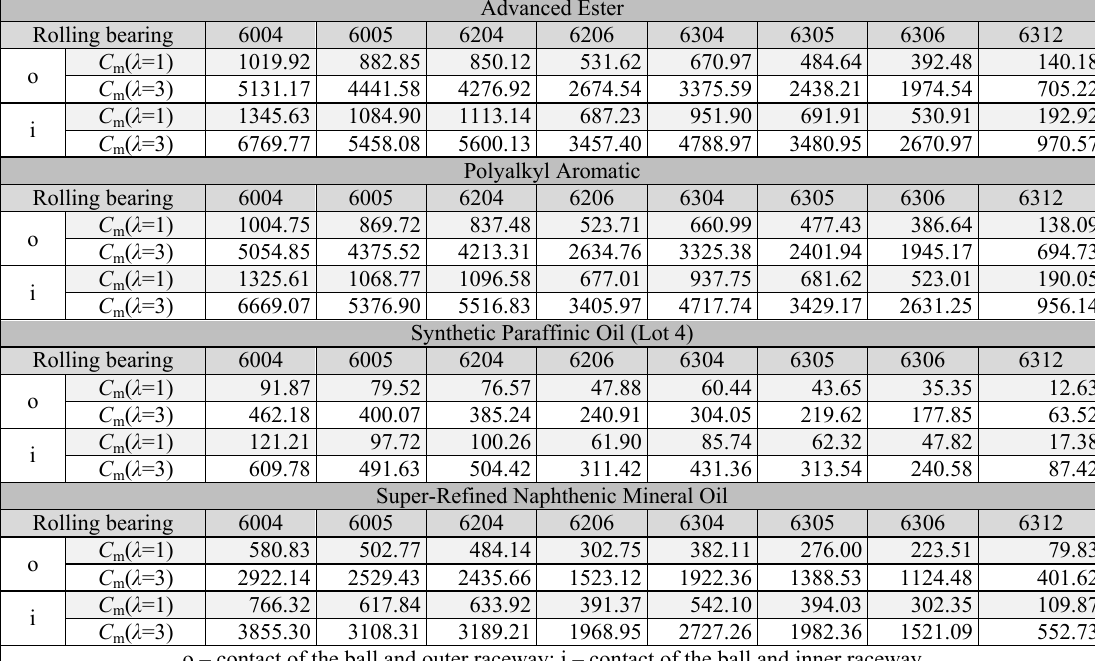
Table 3. Regime lubrication coefficient C m ( λ ) values for four oil lubricants and eight radial ball bearings, with contact surfaces roughness of R ar =0.14 μ m and R ab =0.05 μ m and operating temperature of